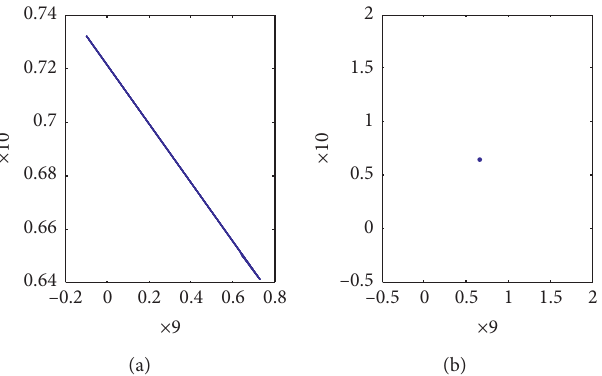
Figure 7: ω � 110 without random perturbation. (a) Phase trajectories. (b) Poincare maps.